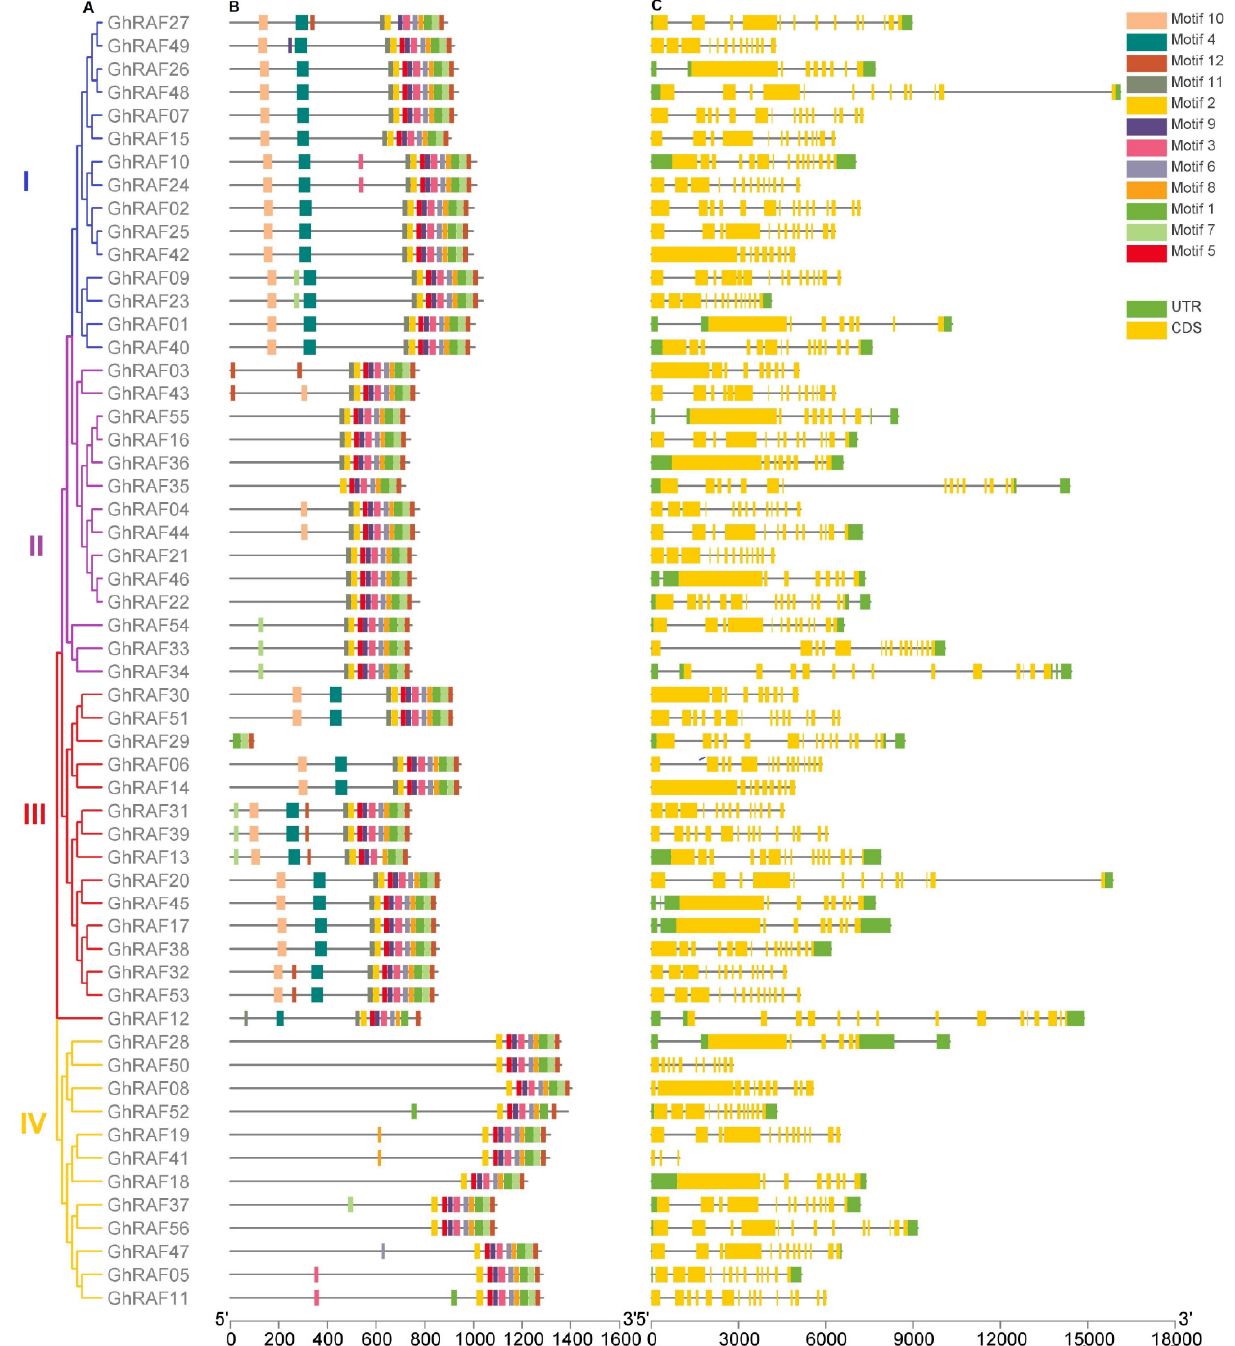
Figure 2. Phylogenetic relationship, motif, and gene structures of RAF gene members in G. hirsutum ( A ) Evolutionary relationship ( B ) Structure of conserved motifs ( C ) Gene architecture.